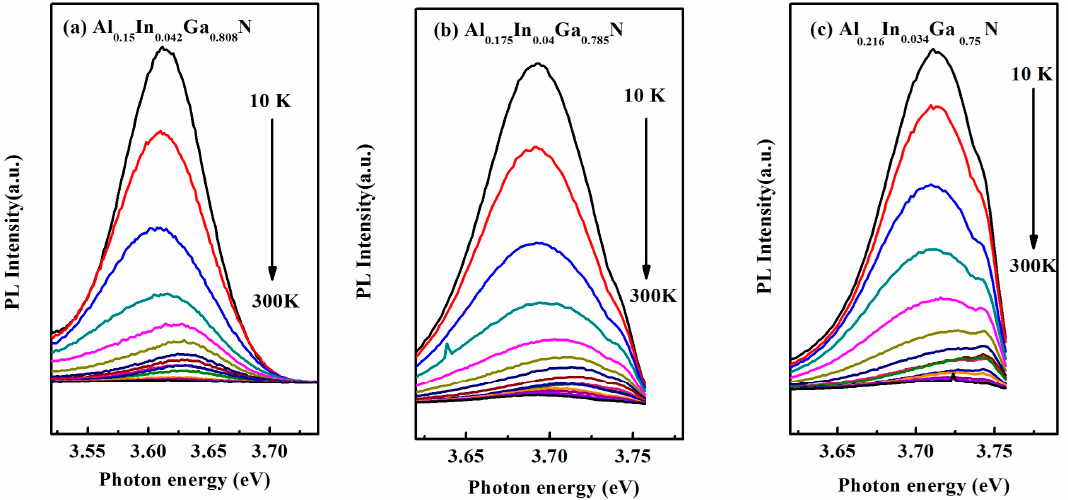
Figure 6. Temperature-dependent photoluminescence (PL) spectra of ( a ) sample 1; ( b ) sample 2; and ( c ) sample 3, at fixed excitation intensity.